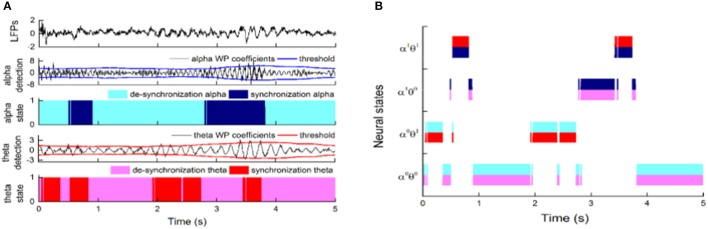
The application of the state identification approach in LFPs and the distribution of neural states based on alpha and theta oscillations. (A) The synchronization states of alpha and theta oscillations were discriminated at the same time. From top to bottom, the images correspond to the LFPs; WP coefficients of alpha oscillation and its adaptive threshold; WP coefficients of theta oscillation and its adaptive threshold; and the distribution of the de-synchronization theta oscillation and synchronization theta oscillation over time. (B) The distributions of four neural states (α0θ0, α0θ1, α1θ0, and α1θ1) based on theta and alpha oscillations in the nucleus over time.